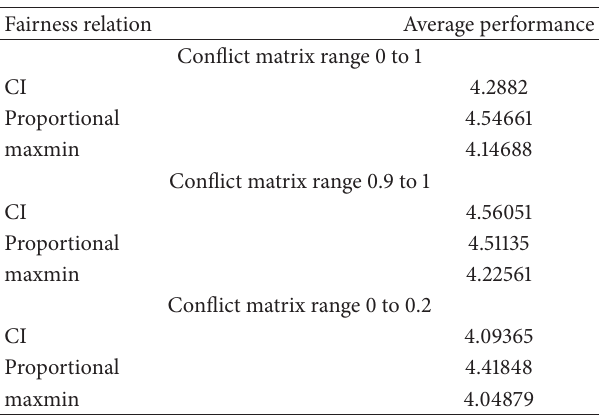
Table 1: Comparison of total performances for capacity, propor- tional, and maxmin